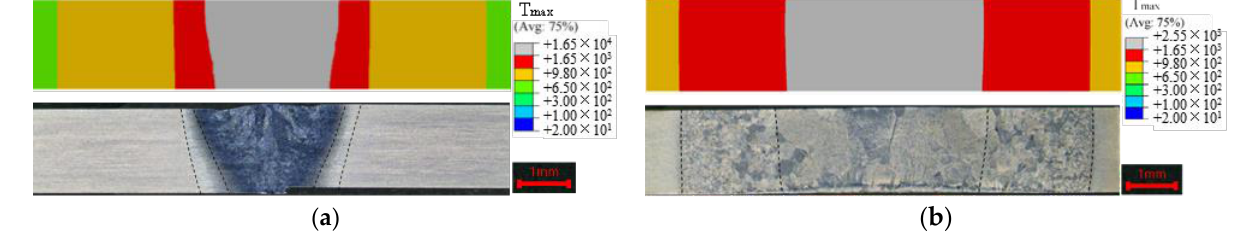
Figure 10. Comparison between the experimental and the simulated weld profiles: ( a ) LBW, ( b ) TIG welding.